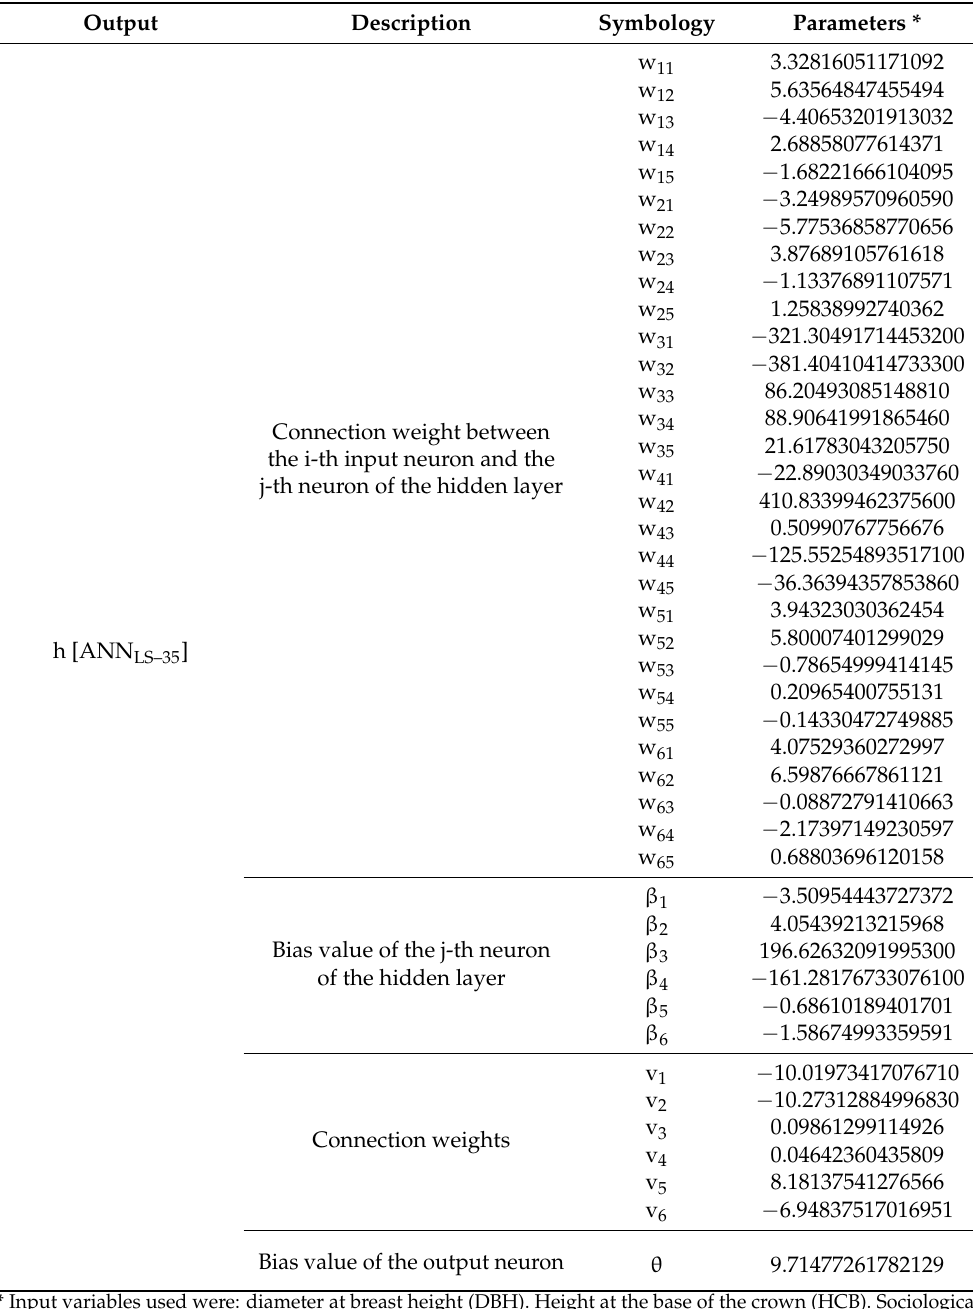
Table 4. Parameters (synaptic weights and biases) of the Artificial Neural Networks (ANN) selected to describe the height of Brazilian